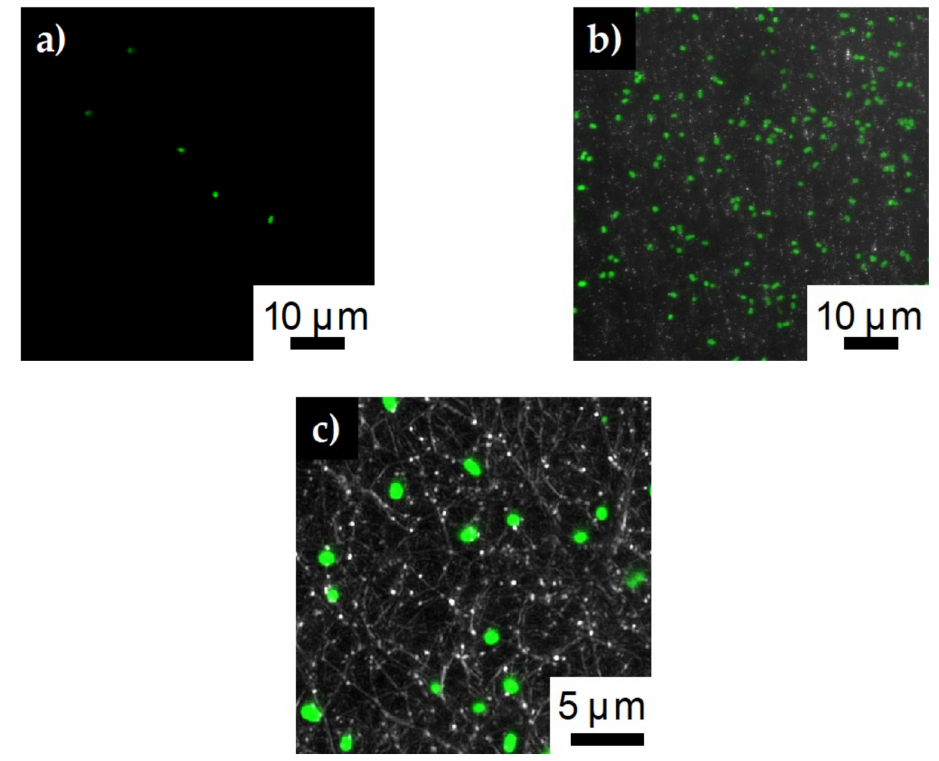
Figure 10. Confocal images of E. coli capture on a ) SDCNF mats and b ) AESF mats at 3 × 10 7 inlet solution concentration. c ) Zoomed in image of AESF fibers to show E. coli is bound to areas